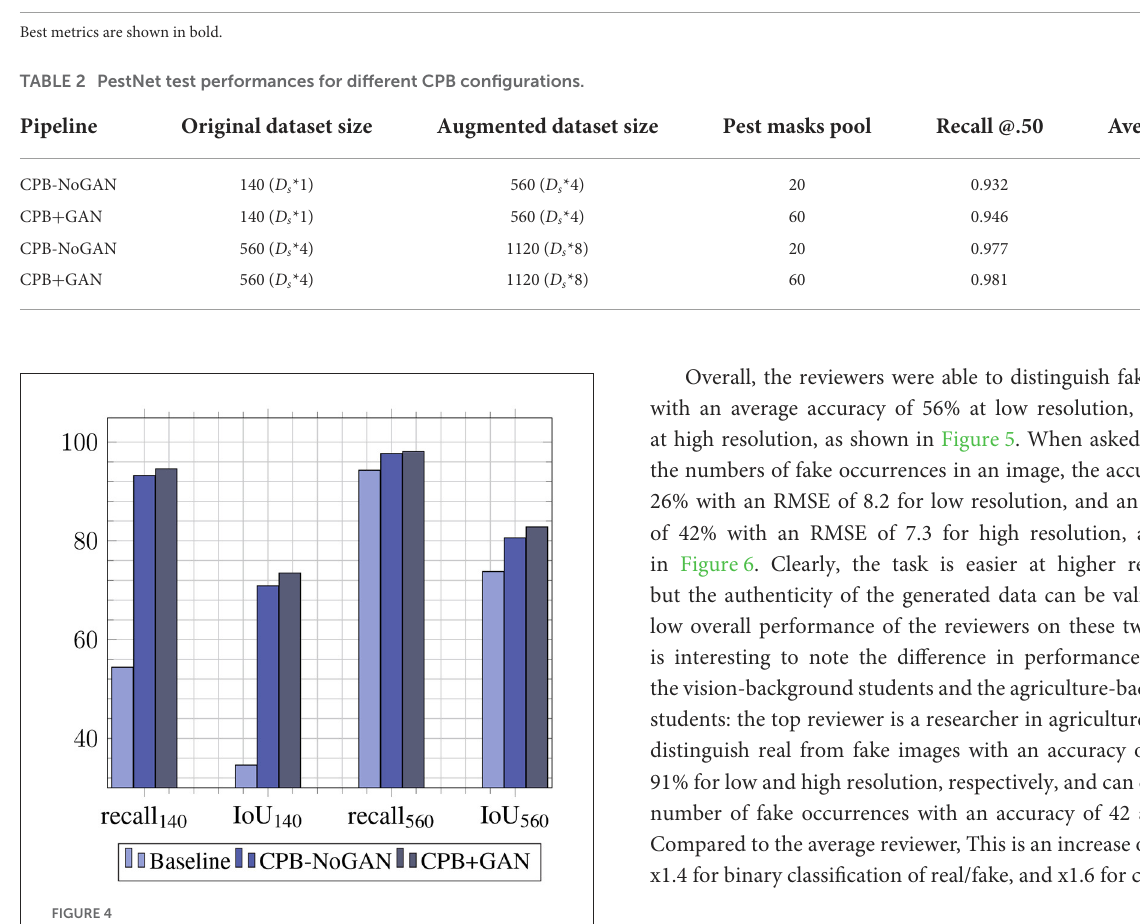
FIGURE4 Performance gains of PestNet with CPB for Recall@.50 and Average IoU.